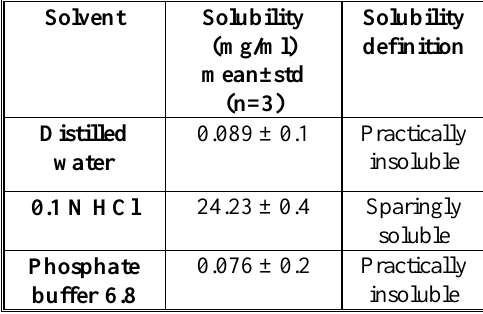
Table 2.The saturated solubility of EXB in different media at 25°C.